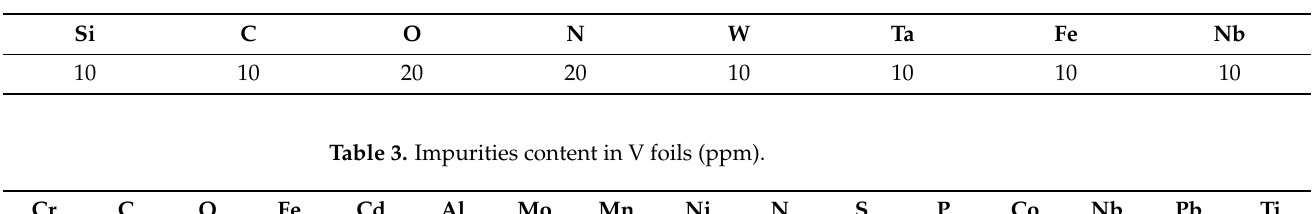
Table 2. Impurities content in Ti foils (ppm).